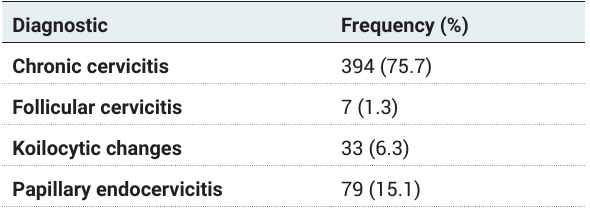
Table 4: Prevalence of various disease conditions in Inflammatory, reactive and reparative lesion category